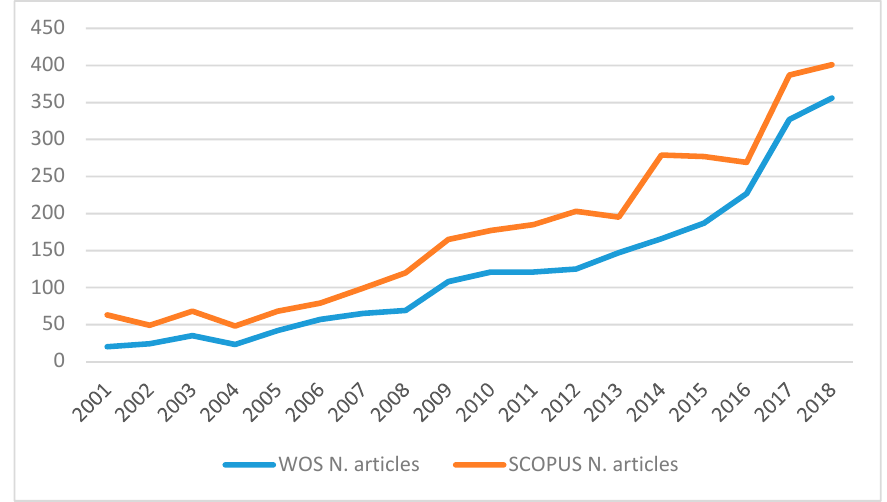
Figure 2. Evolution in number of articles.